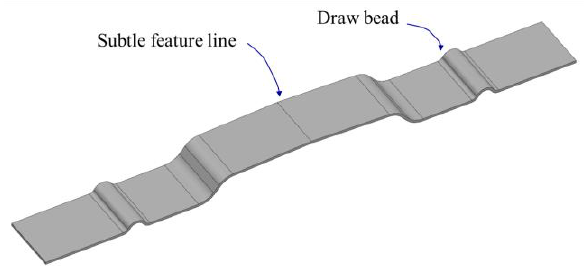
Figure 6. Experimental model with a subtle feature line in the center.